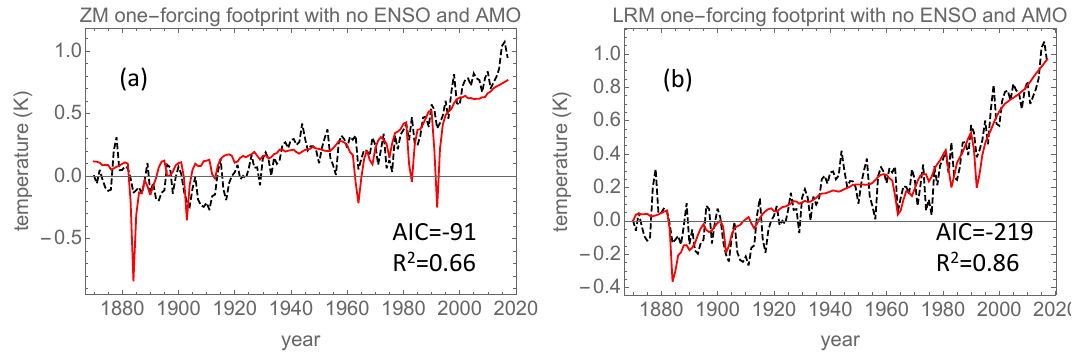
Figure 5. ( a ) The red curve is the total explained GMST (or the total footprint) from the regression when the only predictor (fingerprint) is the unfiltered sum of solar, volcanic and anthropogenic forcing (the total forcing). The black, dashed curve is the HadCrut4 GMST signal. ( b ) The same as ( a ) with the long-memory filtered ( β = 0.6) forcing as a